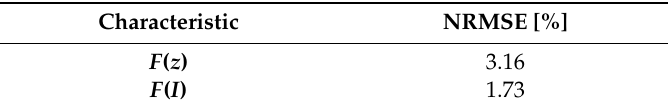
Table 1. Normalized root mean square error (NRMSE) value for characteristics given in Figure 8 for the number of points N = 9.